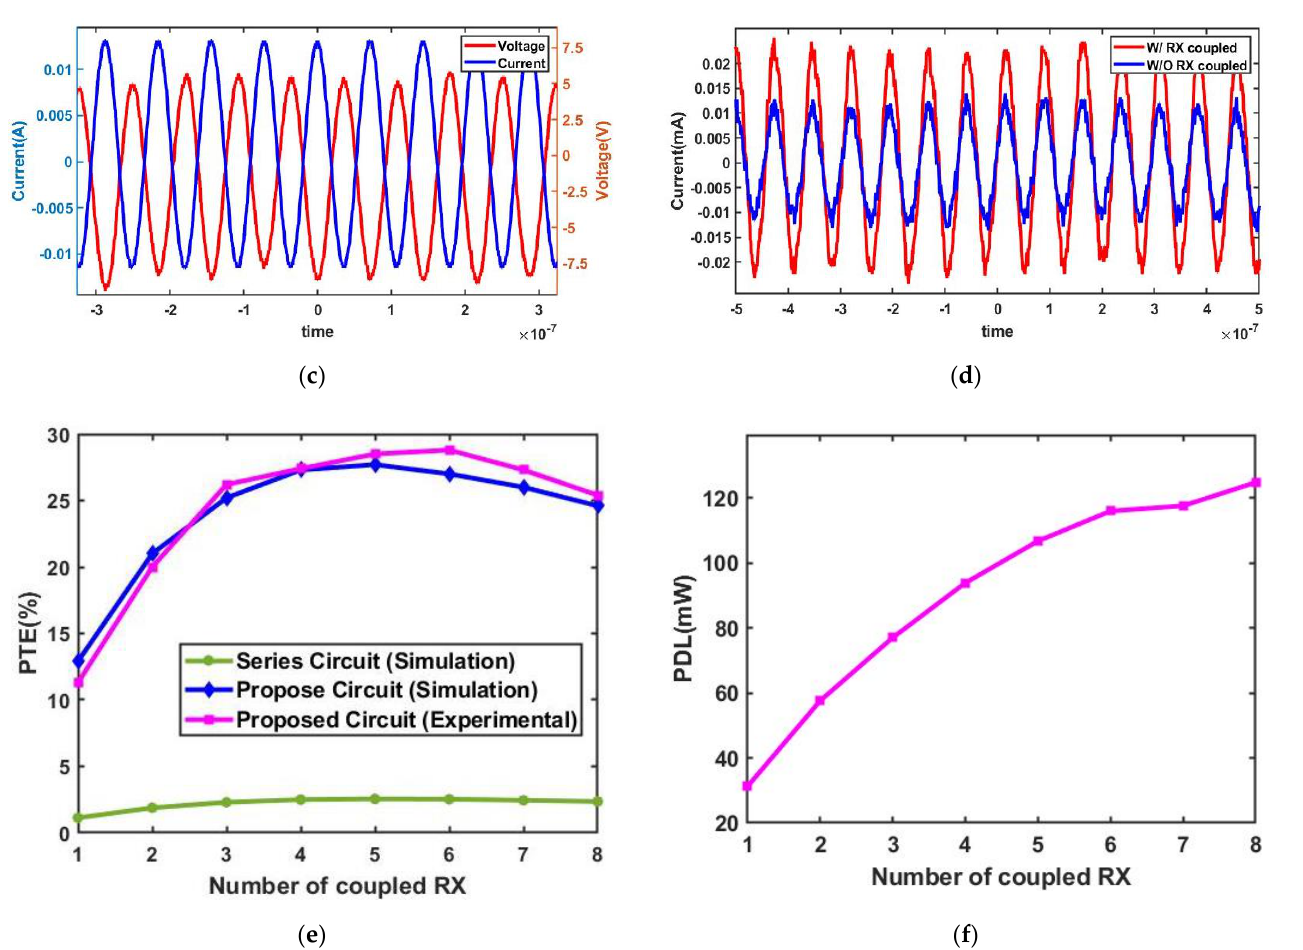
Figure 9. ( a ) The textile part; ( b ) The experiment with function; ( c ) The voltage and current are in-phase when only one RX is coupled; ( d ) The current of the parallel branch coupled with RX and the current of the parallel branch not coupled with RX; ( e ) The PTE of serial simulation results, proposed system simulation results and proposed system experimental results; ( f ) Using CMCD to power n ( n = 1 to 8) RX, the PDL of RX.